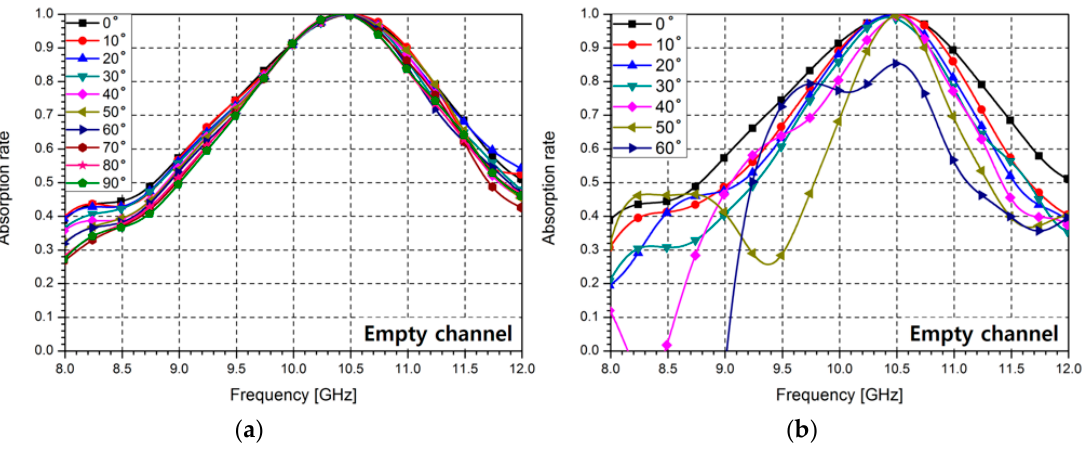
Figure 8. Simulated and measured absorption rates of the proposed metasurface absorber.